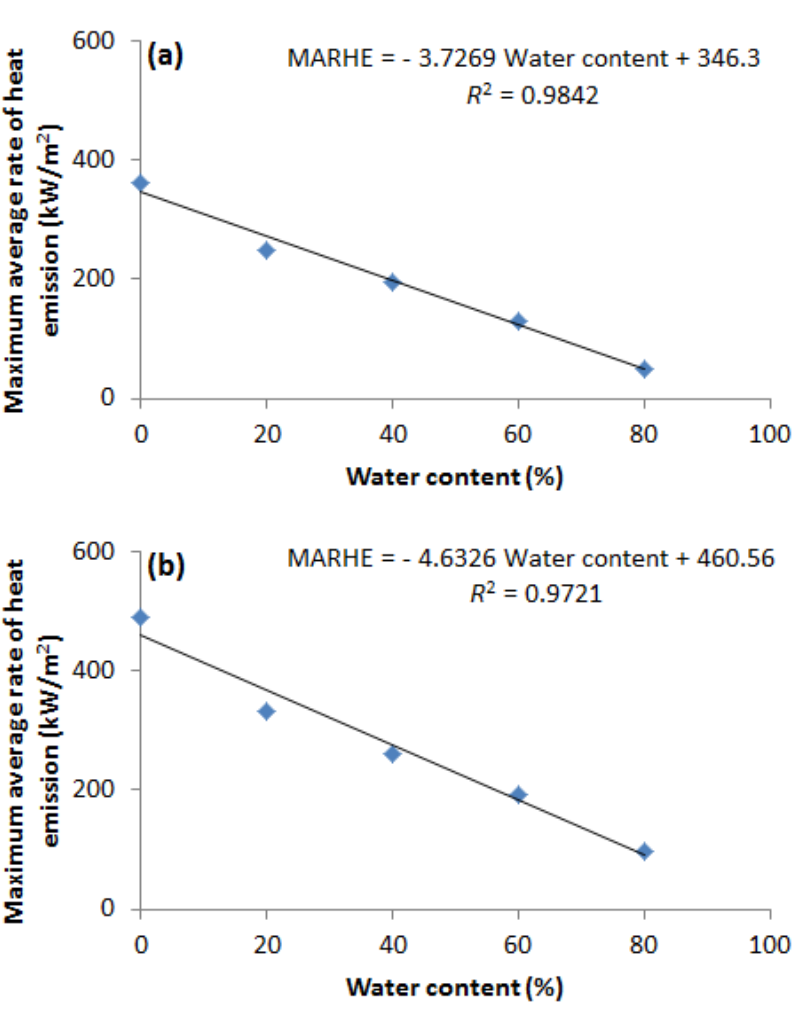
Figure 4. Dependency of the maximum average rate of heat emission of investigated fuels on the water content: ( a ) Dependency of the maximum average rate of heat emission of methanol on the water content; ( b ) Dependency of the maximum average rate of heat emission of ethanol on the water content (MARHE: maximum average rate of heat emission).